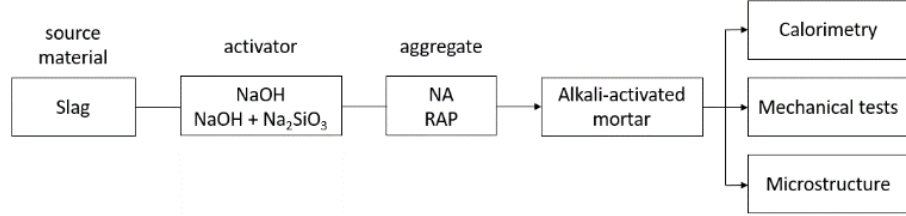
Figure 1. Research flow-chart.